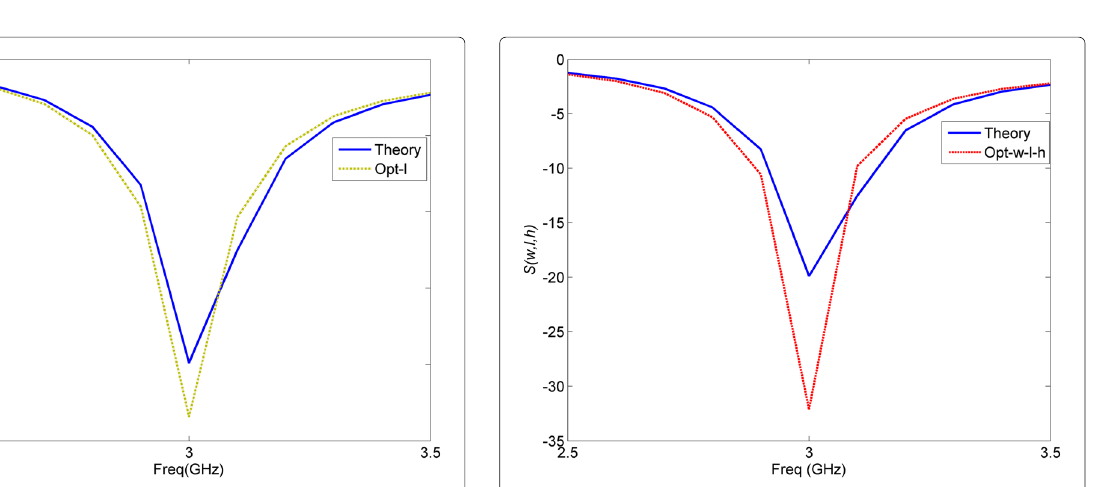
Fig. 5 Comparison of theoretical solution versus the solution through optimizing w , l , and h by